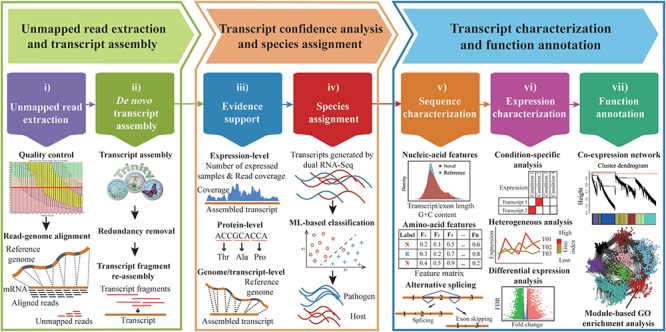
Overview of CAFU.